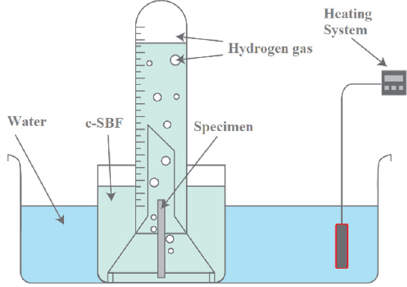
Figure 2. Hydrogen gas evolution method set up.